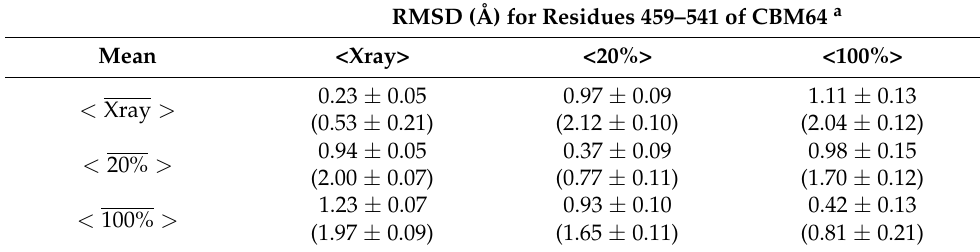
Table 2. The Comparison of the Crystal and NMR Structures of